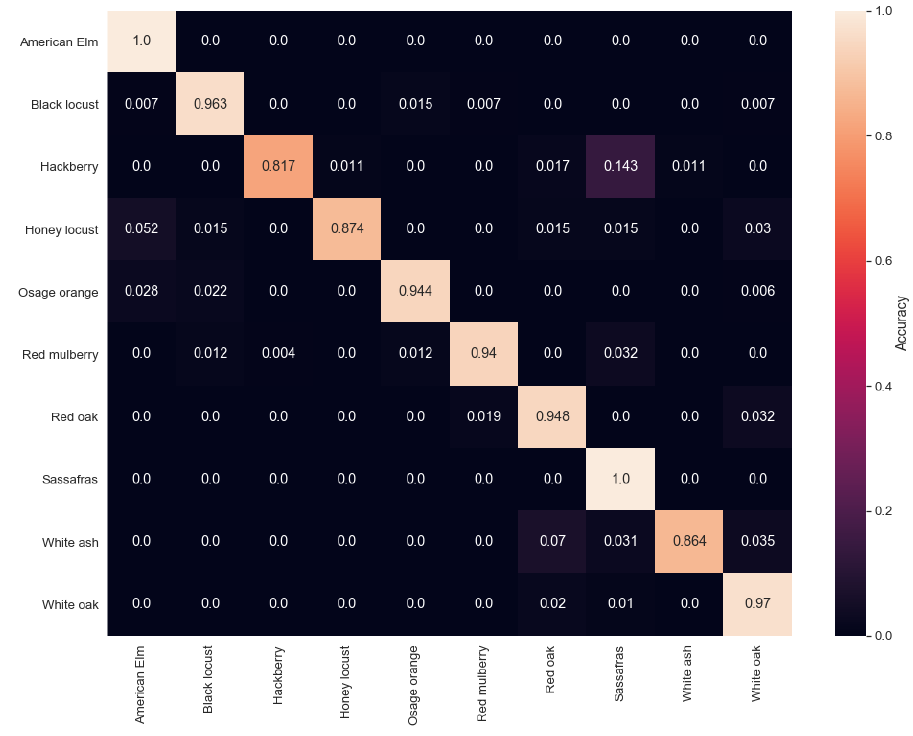
Figure 6. Averaged confusion matrix of the ten North American hardwood species.